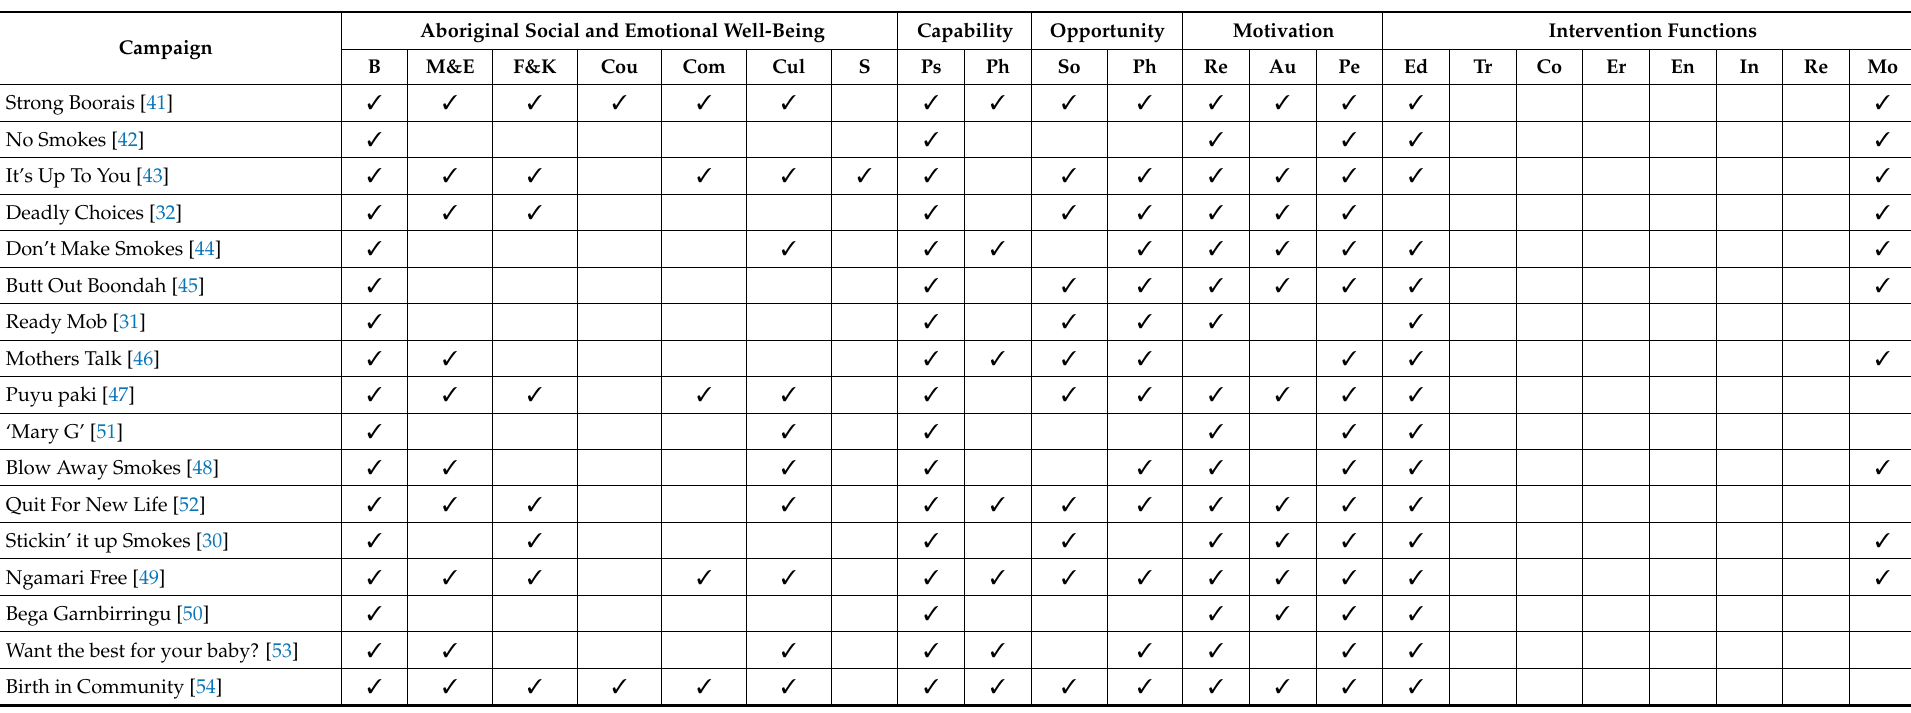
Table 5. Alignment of health promotion materials with the domains of Aboriginal Social and Emotional Wellbeing Model and Behavior Change Wheel. Aboriginal Social and Emotional Well-Being Capability Opportunity Motivation Intervention Campaign